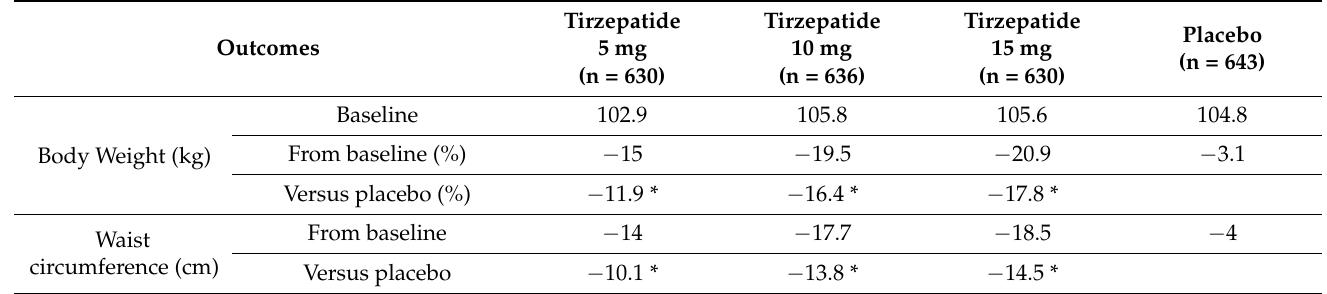
Table 6. Results of the SURMOUNT-1 trial at 72 weeks [66]. Efficacy analyses were done in the mITT population; * p <